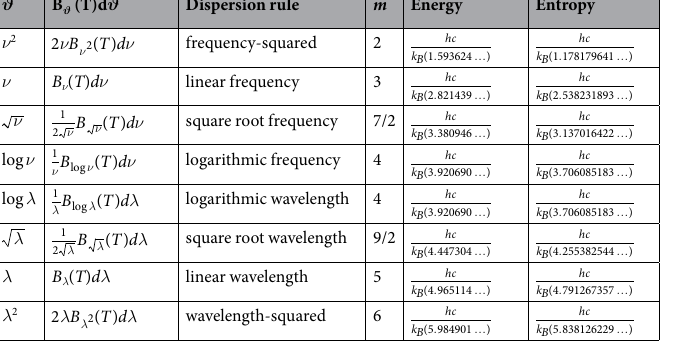
Table 1. Wien’s peaks for the energy and the entropy of radiation for different dispersion rules, corresponding to different values of the dispersion coefficient m